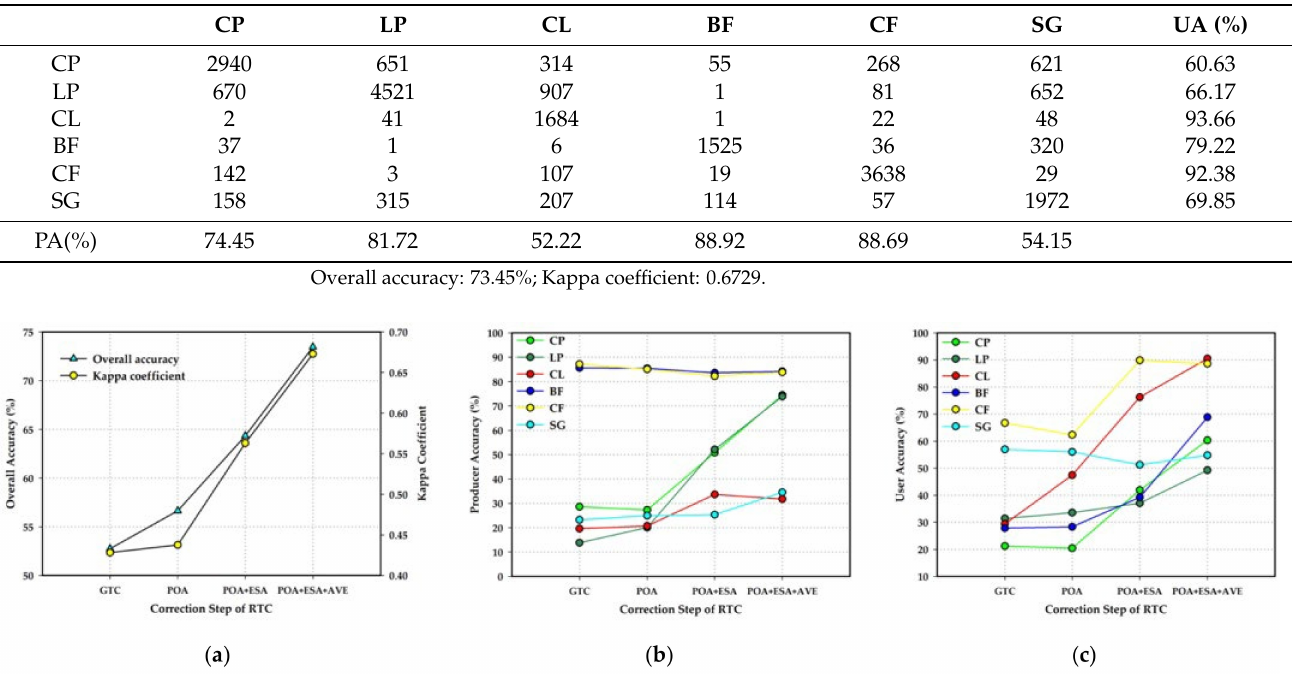
Figure 12. The overall accuracy, Kappa coefficient, producer accuracy, and user accuracy of different classes in different correction steps: ( a ) overall accuracy and Kappa coefficient; ( b ) producer accuracy; ( c ) user